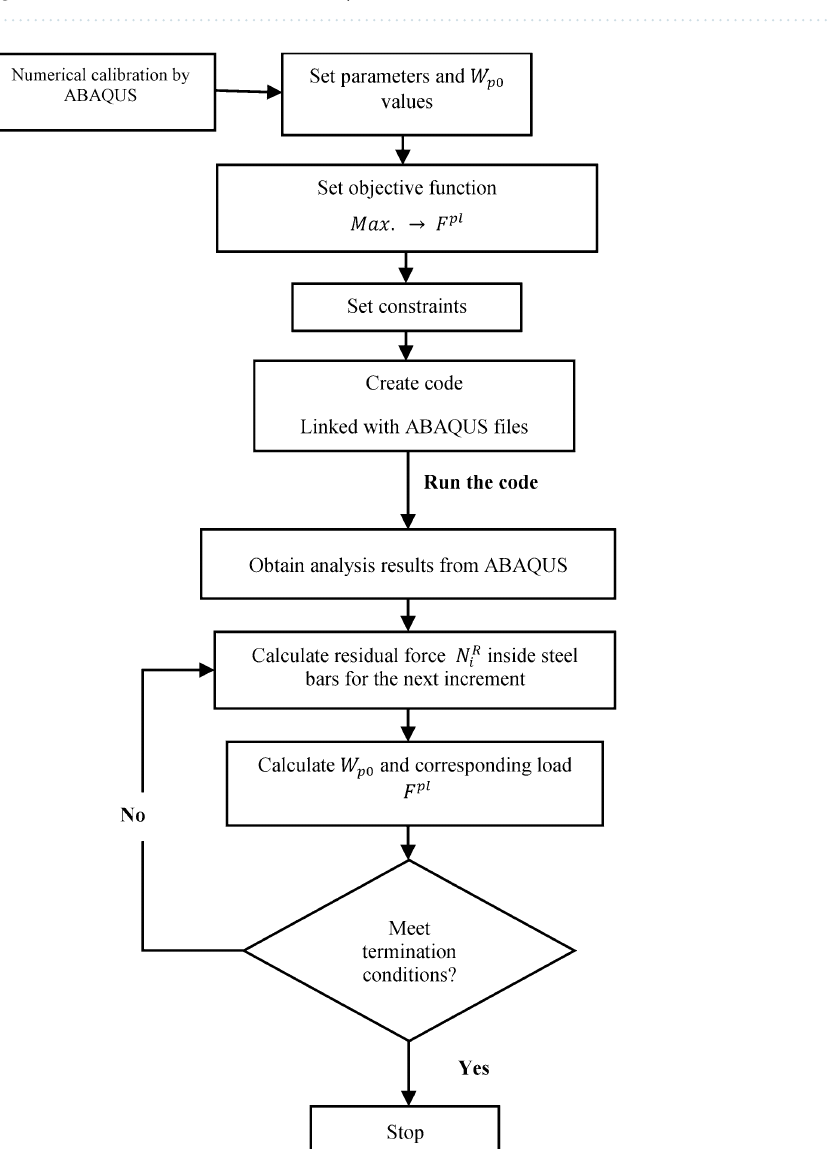
Figure 13. Optimization